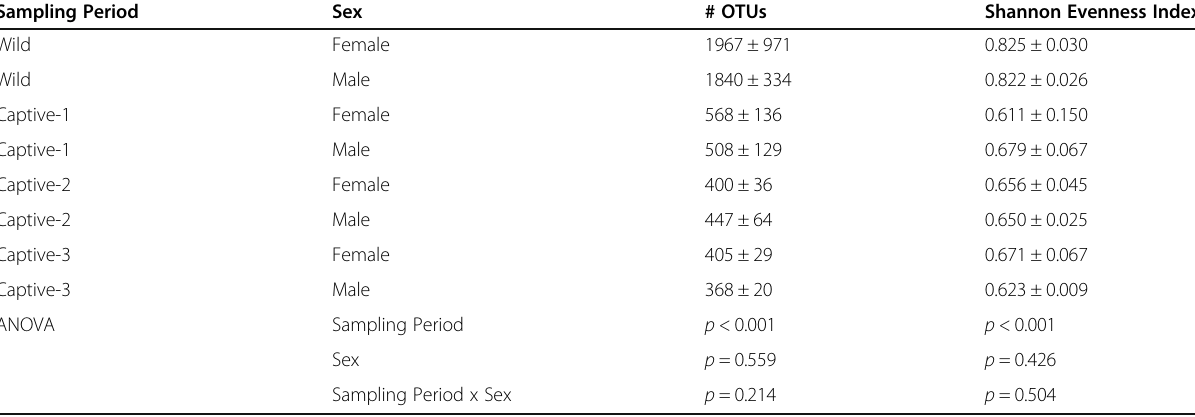
Table 3 Diversity statistics within the external microbiota of adult common snook Sampling